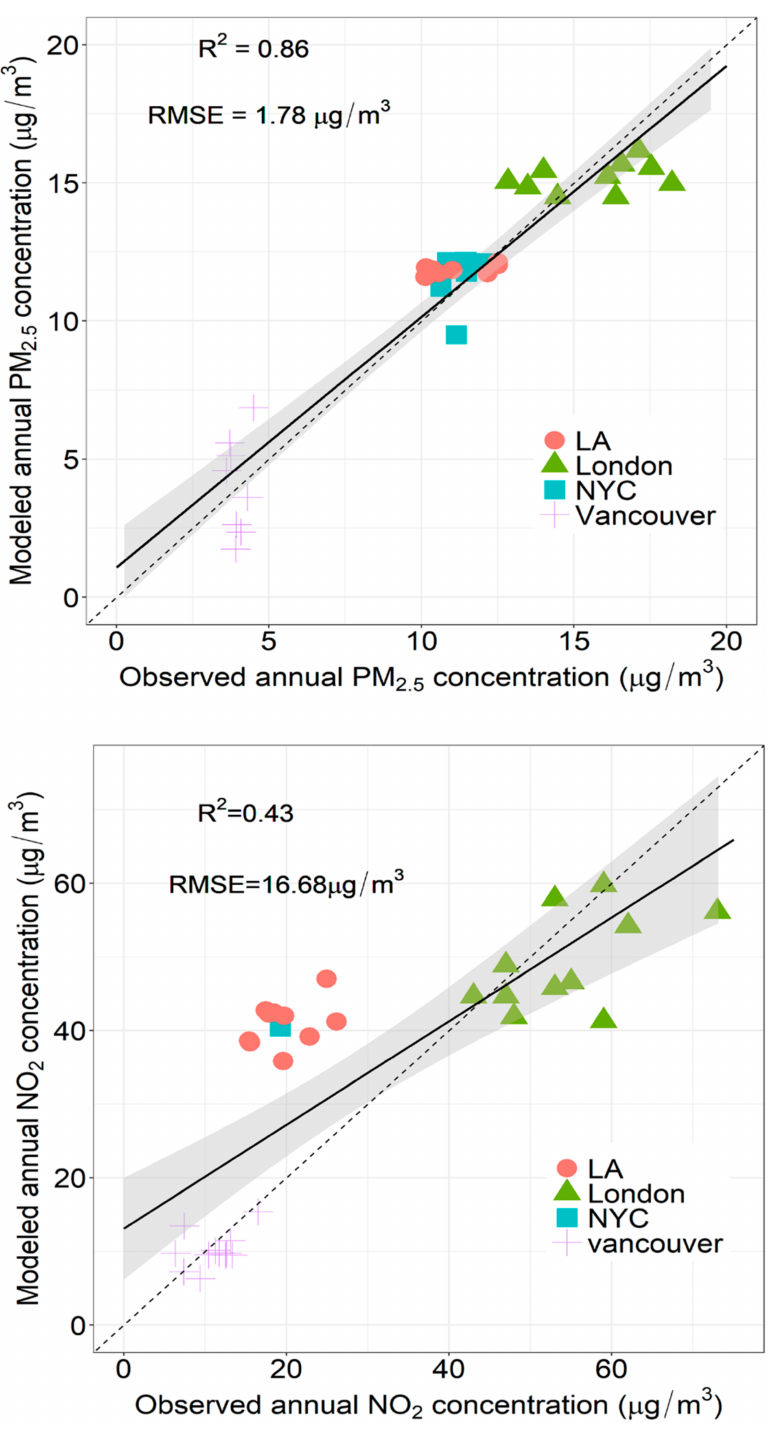
Figure 5. Correlations between observed and predicted PM 2.5 and NO 2 concentrations. Correlations between observed PM 2.5 ( upper panel ) and NO 2 ( lower panel ) concentrations at ground monitoring sites and predicted values based on our model; the dashed line is the 1:1 line and the black line is the regression line with 95% confidence intervals (R 2 = 0.86, 0.43, and RMSE = 1.78, 16.68 µ g/m 3 , respectively). Only sites that had co-located model-estimated values within a distance less than 500 m were included. For London, daily station data was used to calculate annual means of measured pollution over ground stations that had at least one measured value every month. For the other cities, annual means of measured data were used for the stations that had collected data for over 50% of the